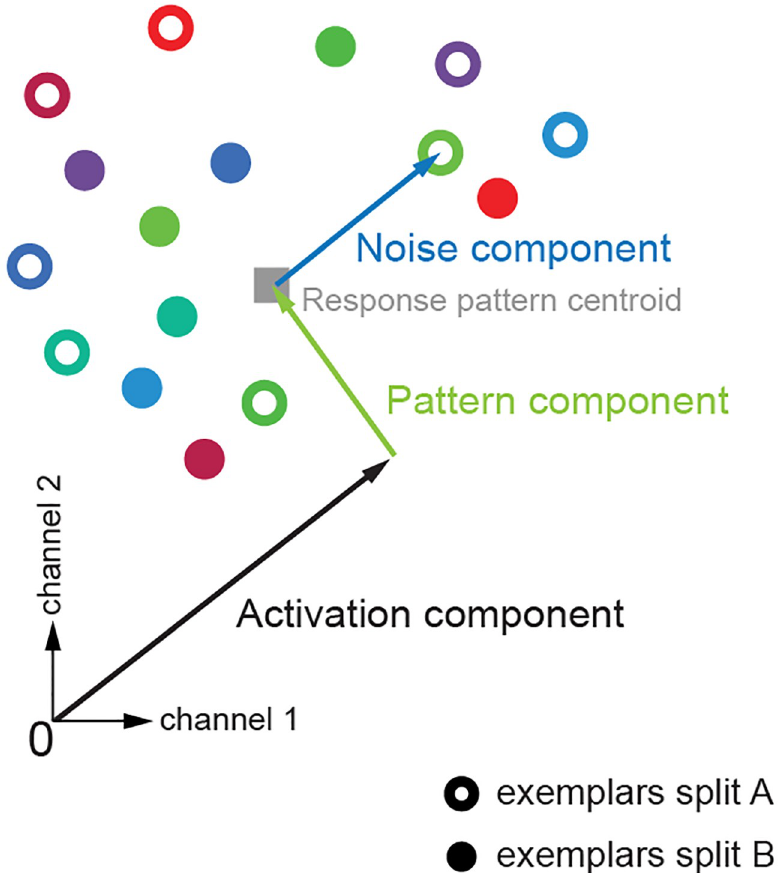
Fig 4. H 0 simulation settings. We use simulations to test the distribution of EDIs under the null hypothesis, H 0 (here illustrated for only two response channels). For both datasets 1 and 2, patterns of exemplars were simulated in a multi- dimensional response space. The number of dimensions of the response space is the same as the number of response channels (e.g. voxels in a region of interest in fMRI data). Response patterns were simulated by first moving along the all-ones vector to reach the average activation, whose strength was determined by the activation component . A Gaussian pattern with a pattern component variance was added to the activation component , resulting in the response pattern centroid. Individual exemplars of each data split were then generated by adding random Gaussian noise with a noise component variance to the centroid. At each iteration of the simulation, the same centroid underlay all exemplars in both data splits (as exemplars are indiscriminable under H 0 ). Exemplar labels were randomly assigned to experimental conditions and their repetitions. For details of the simulations see section